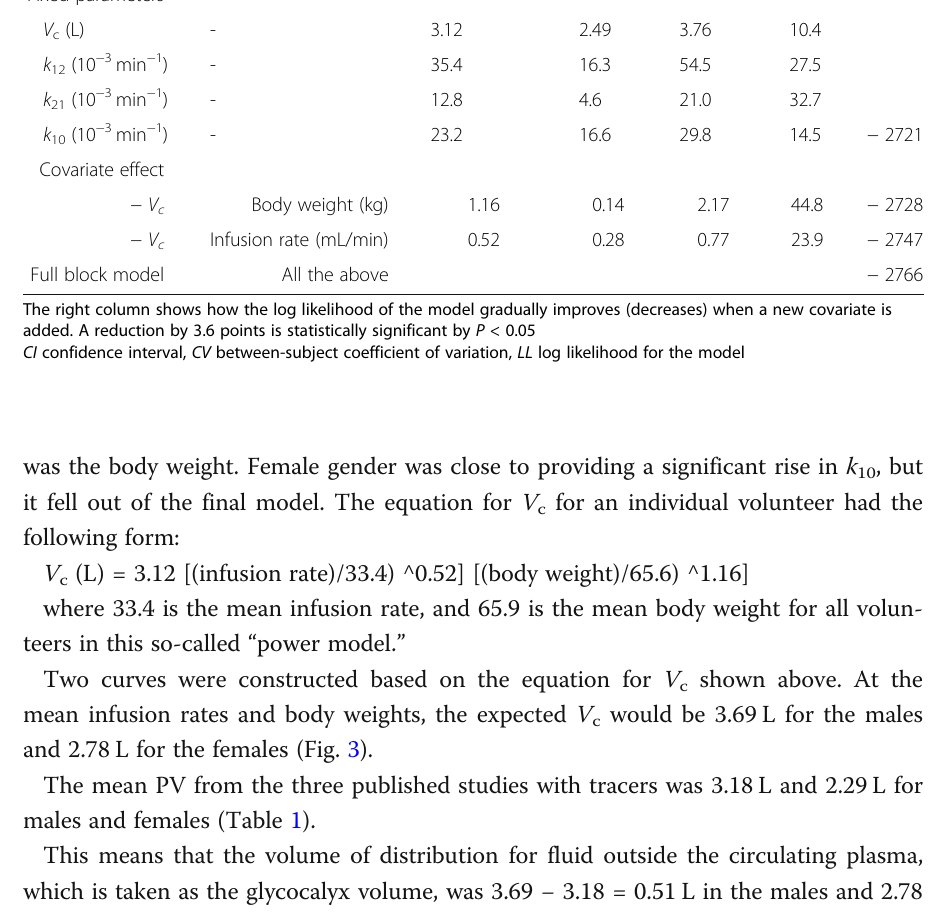
Table 2 Population kinetic parameters in the final model for infusion experiments conducted in 35 volunteers